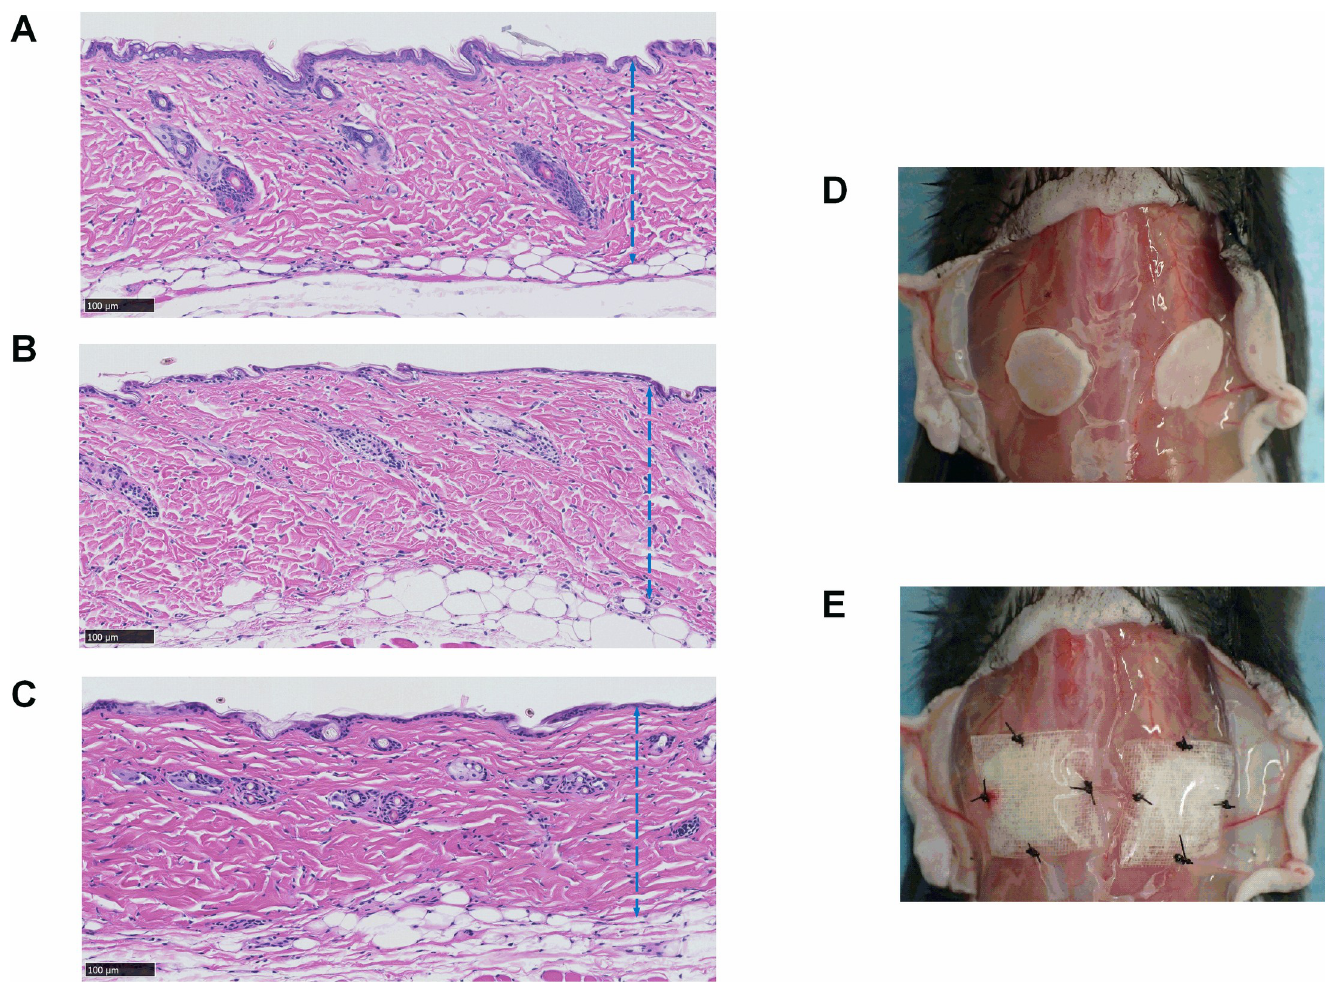
Fig 1. Micrographs of the inactivated skin grafts by HHP and photographs of grafting procedures. (A) A micrograph of murine skin before HHP, (B) a micrograph of murine skin just after HHP, (C) a micrograph of murine skin after 4 weeks cryopreservation; the blue broken lines indicate the dermis of grafts, (D) a gross photo of the inactivated graft position, (E) gross photos of the grafts covered by NSS- or bFGF-impregnated (sandwich-technique) CGSs. Magnification: 20x, scale bar: 100 μ m.